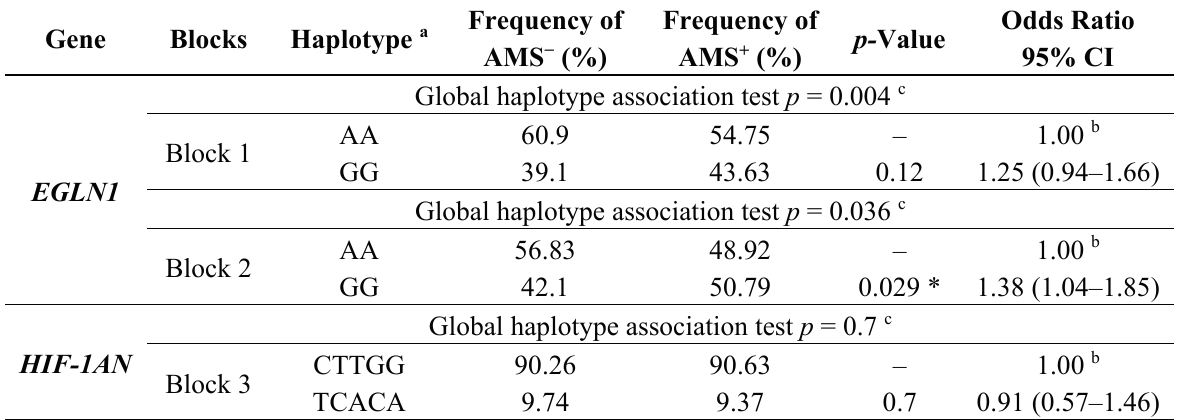
Table 4. Haplotype frequencies and the association with AMS risk adjusted for age and smoking status.